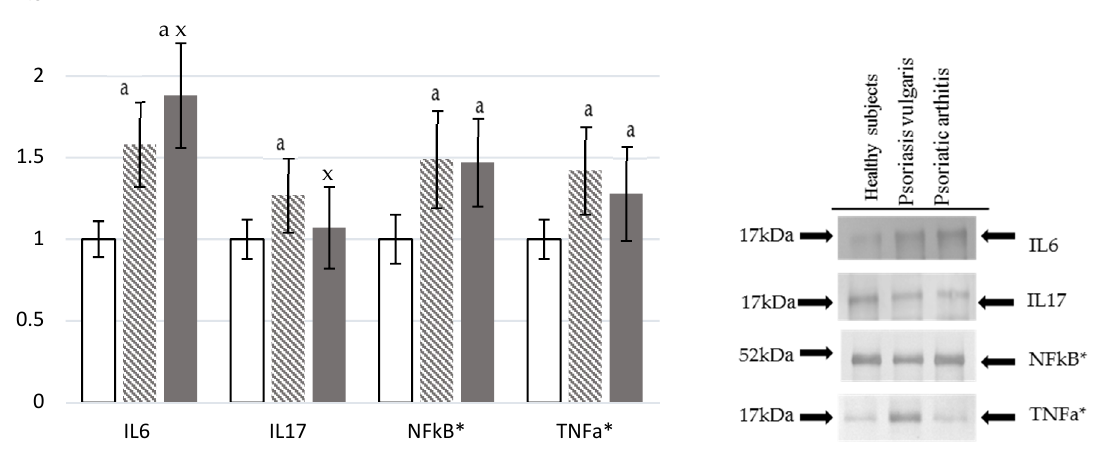
Figure 5. The levels of interleukins and pro-inflammatory mediators in plasma or granulocytes* from healthy subjects (n = 8) and patients with psoriasis vulgaris (n = 16) and psoriatic arthritis (n = 8). a p < 0.05 when compared with healthy subjects. x p < 0.05 when compared with patients with psoriasis vulgaris.